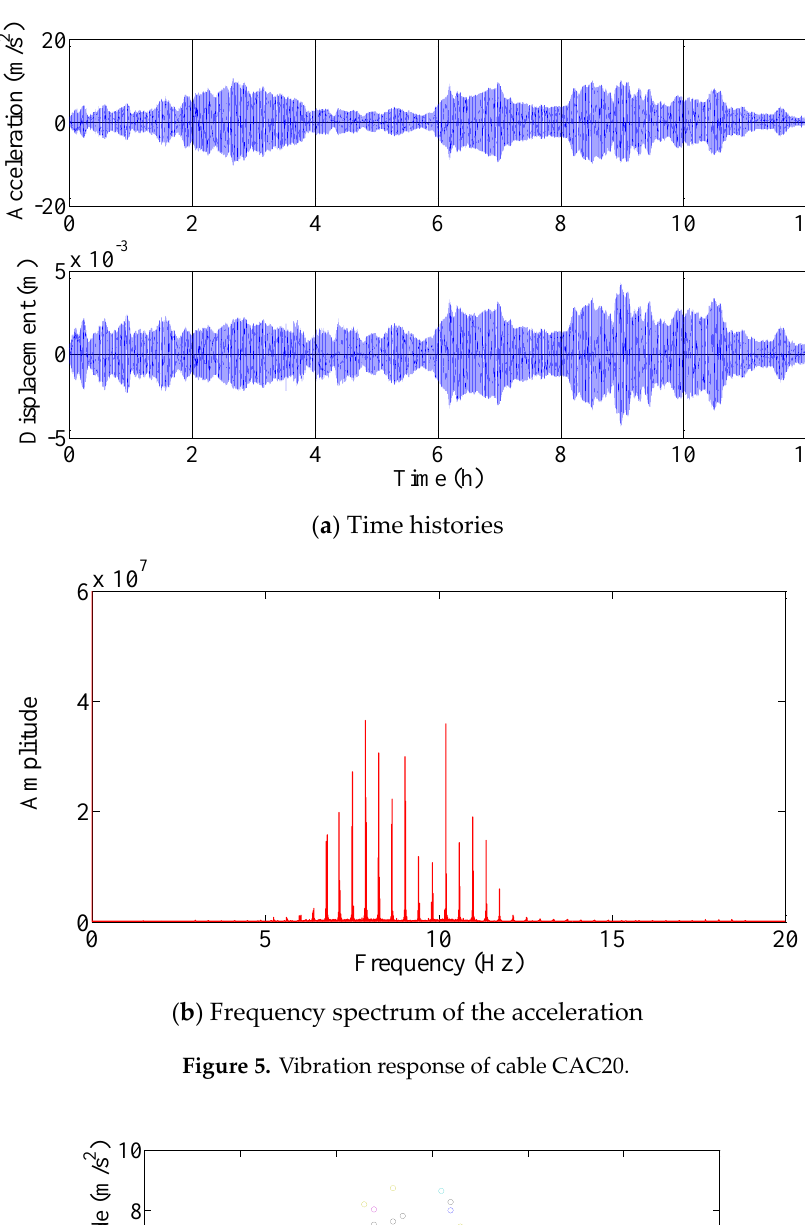
Figure 5. Vibration response of cable CAC20.